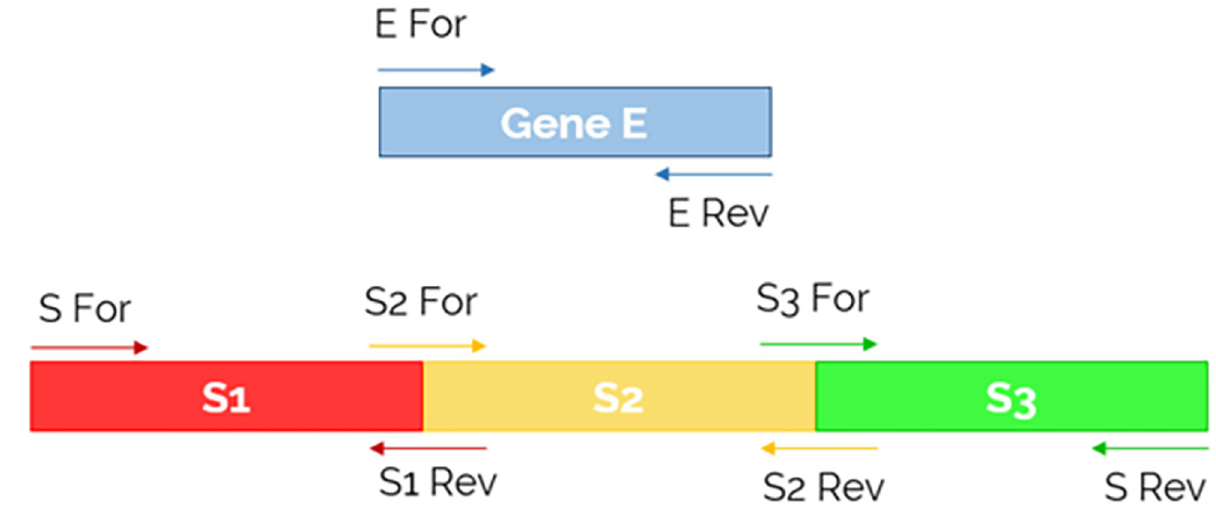
Fig 1. Primer position within the gene of interest. The Fig schematically display where primers adopted for reverse-transcription, amplification and sequencing of the E (light blue) and S (red, yellow and green) genes map within the viral regions of interest. While a single pair of oligonucleotides were designed to amplify and sequence the entire E gene, one couple of external primers along with two additional pairs of internal primers were used in the case of the S gene. “E For” stands for primer E forward; “E Rev” for primer E reverse, “S For” for primer S forward; “S1 Rev” for primer S1 reverse; “S2 For” for primer S2 forward; “S2 Rev” for primer S2 reverse, “S3 For” for primer S3 forward; “S Rev” for primer S